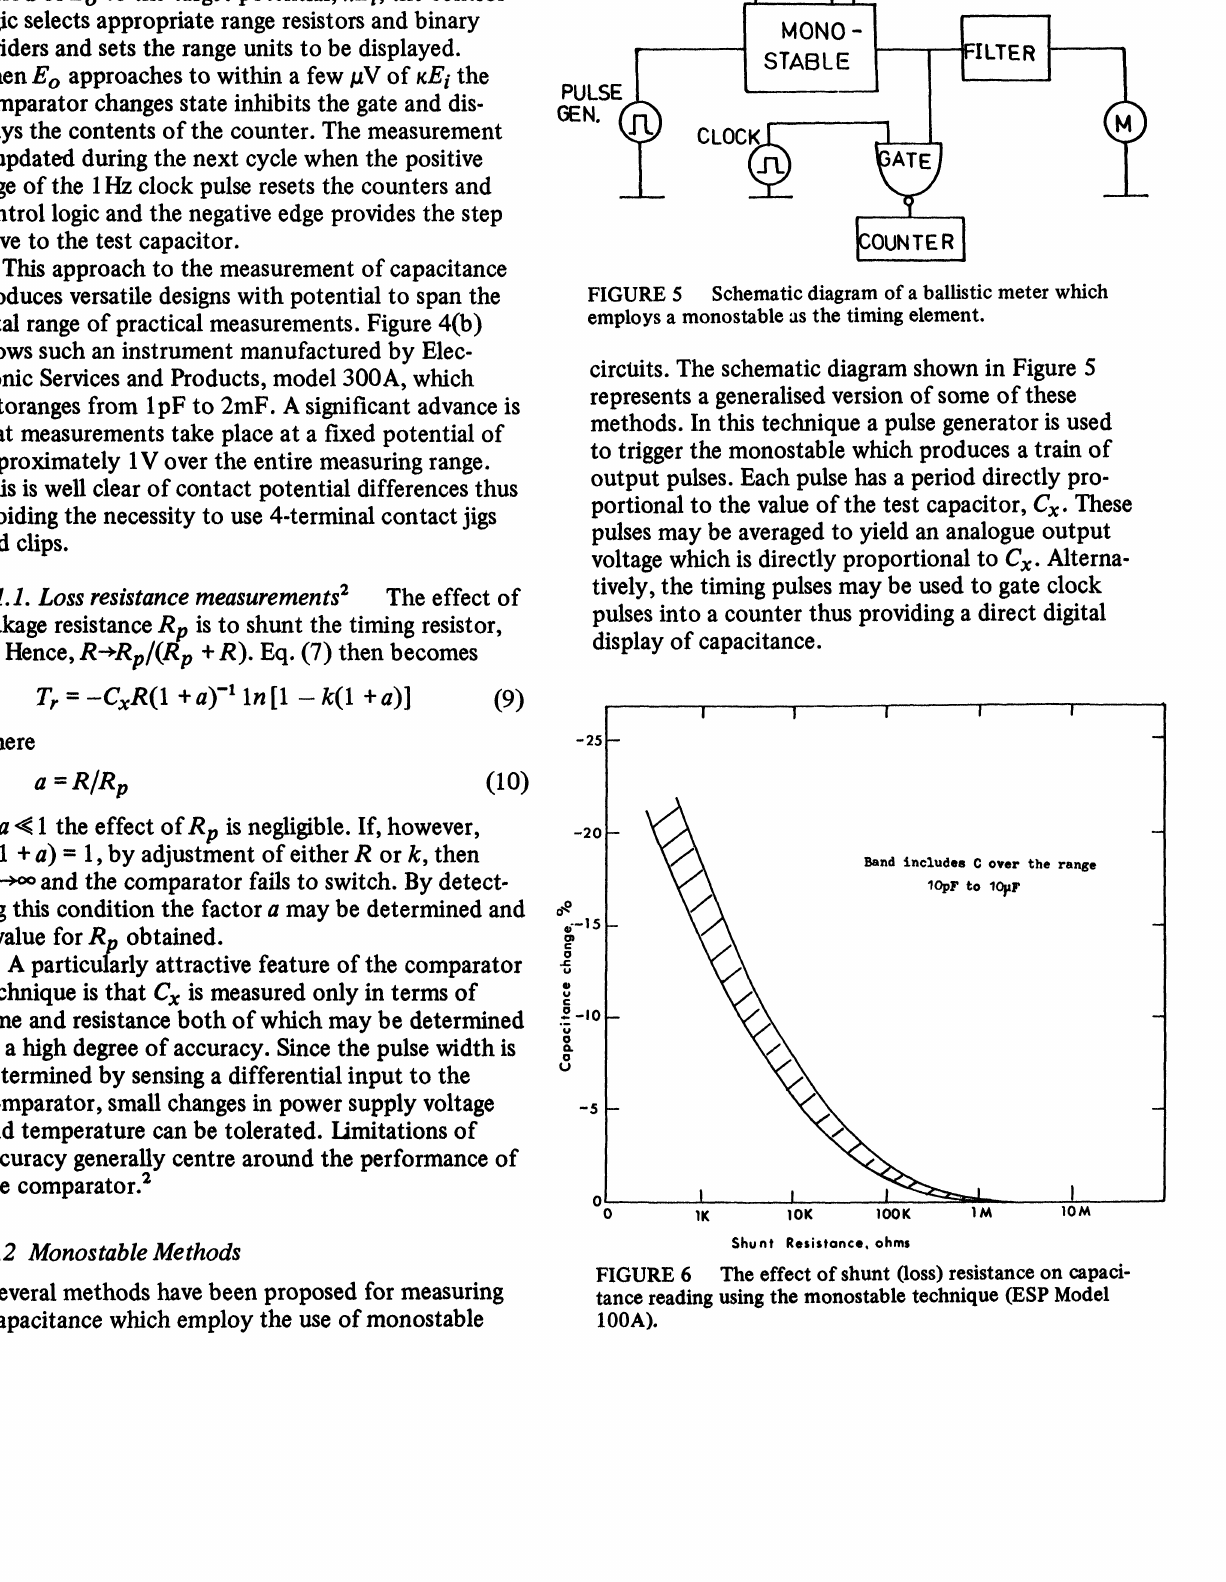
FIGURE 5 Schematic diagram of a ballistic meter which employs a monostable as the timing element. circuits. The schematic diagram shown in Figure 5